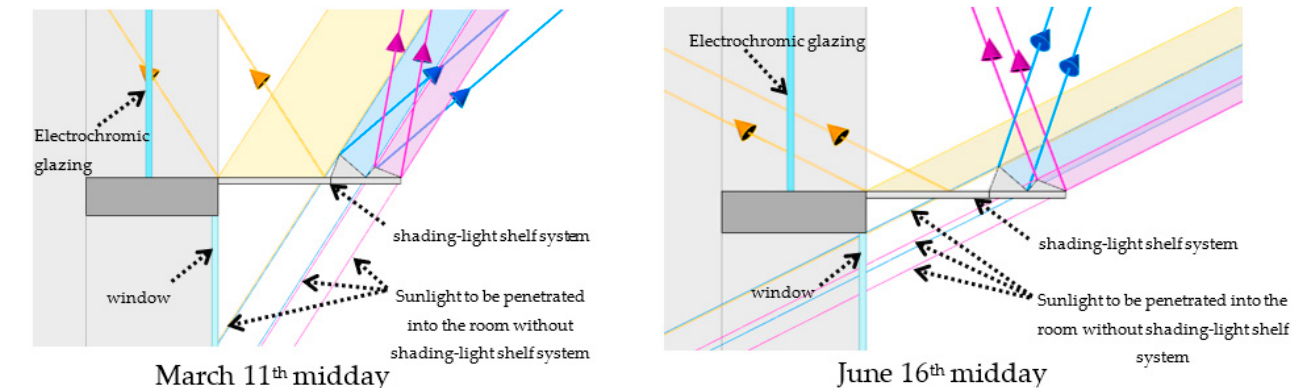
Figure 6. Examples of hourly analysis on the amount of admi tt ed sunlight into the space and the required level of tint in electrochromic